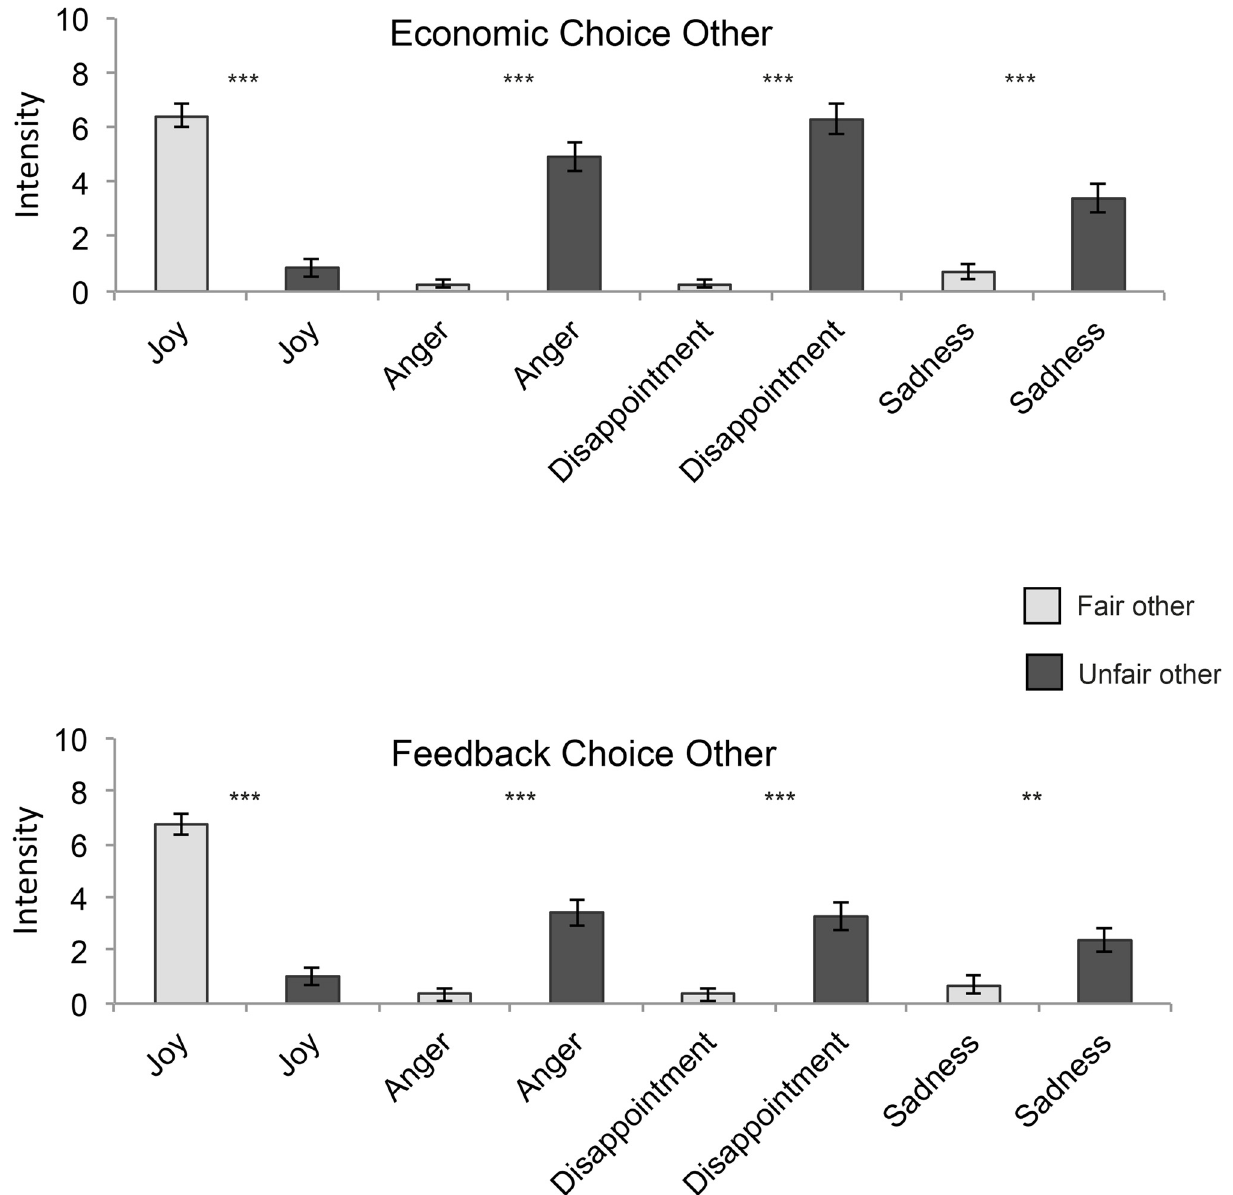
Fig 2. Self-reported feelings in response to the fair other ’ s and the unfair other ’ s economic choices (A) and feedback choices (B) during the low power phase of the Inequality Game. Charts depict means and 2 standard errors of the mean. *** p < .001; ** p <